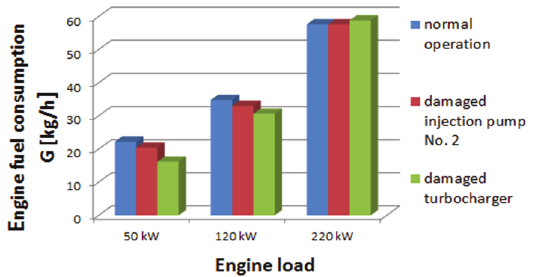
Fig. 4. Fuel consumption by a marine engine for three loads in different engine